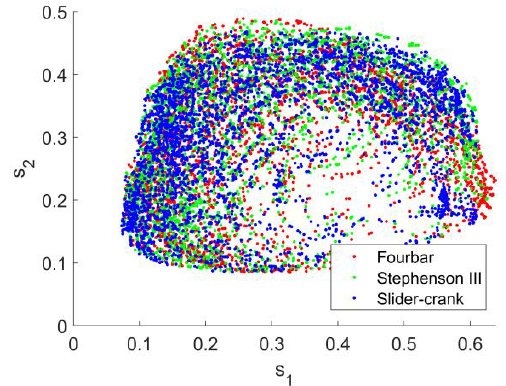
Figure 9. Compressed CAD features of the library; the points with red, green, and blue colors represent four-bar type, Stephenson III, and slider-crank mechanisms,